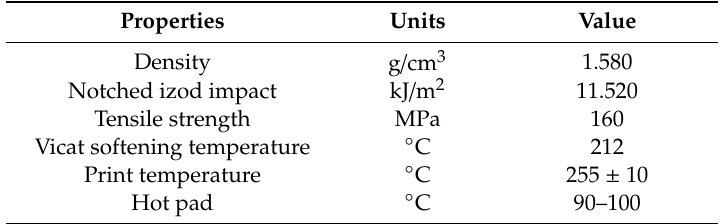
Table 1. Mechanical, physical properties and printing FDM characteristics for Nylstrong GF–PA6.